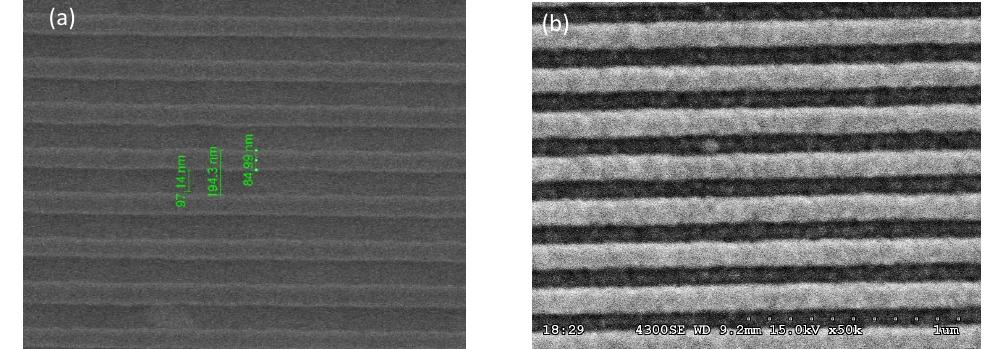
Figure 2. Scanning electron microscope (SEM) images of the fabricated samples. ( a ) 200 nm-period PMMA nanograting. ( b ) Gold thin film coated 200 nm-period nanograting.